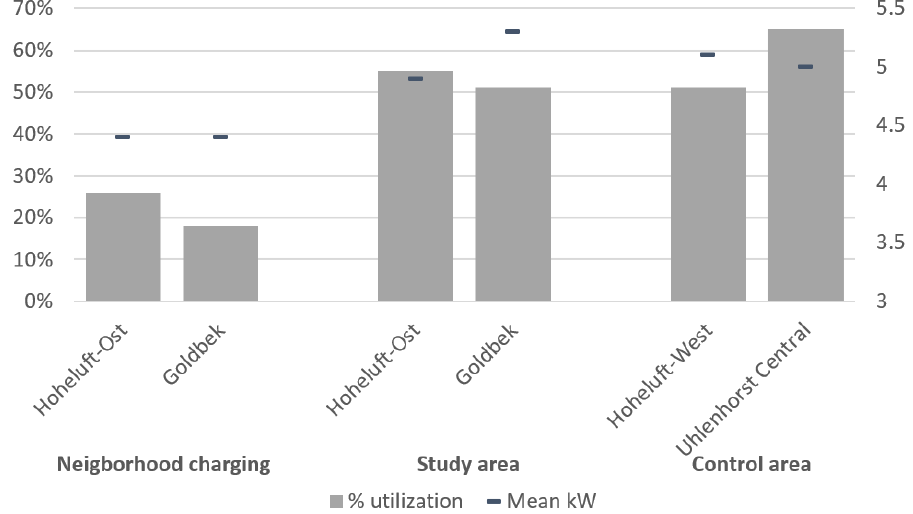
Figure 3. Utilization of public charging infrastructure in different concepts.